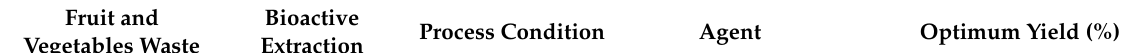
Table 7. Progress studies of FVW involving pressurized liquid